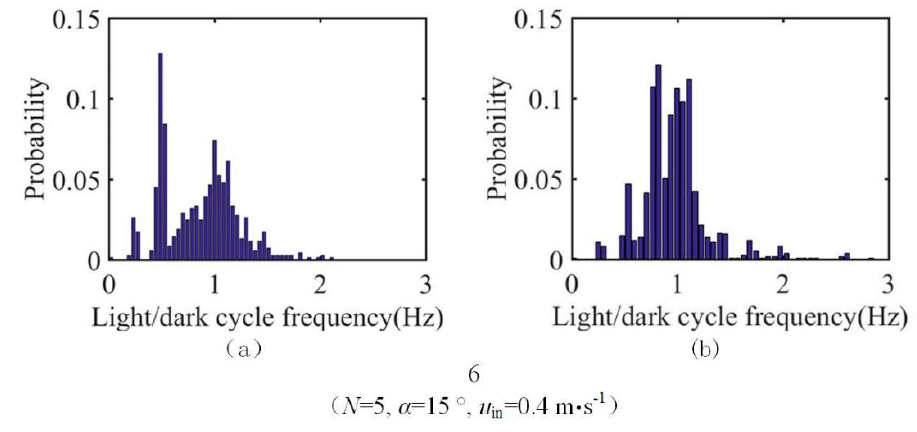
Figure15. ProbabilitydensitiesoftheL / Dcyclefrequencyforgroup6under( a )single-sidedillumination Figure 15. Probability densities of the L/D cycle frequency for group 6 under ( a ) single-sided conditions; and ( b ) conditions shown in Figure illumination conditions; and ( b ) conditions shown in Figure 13.